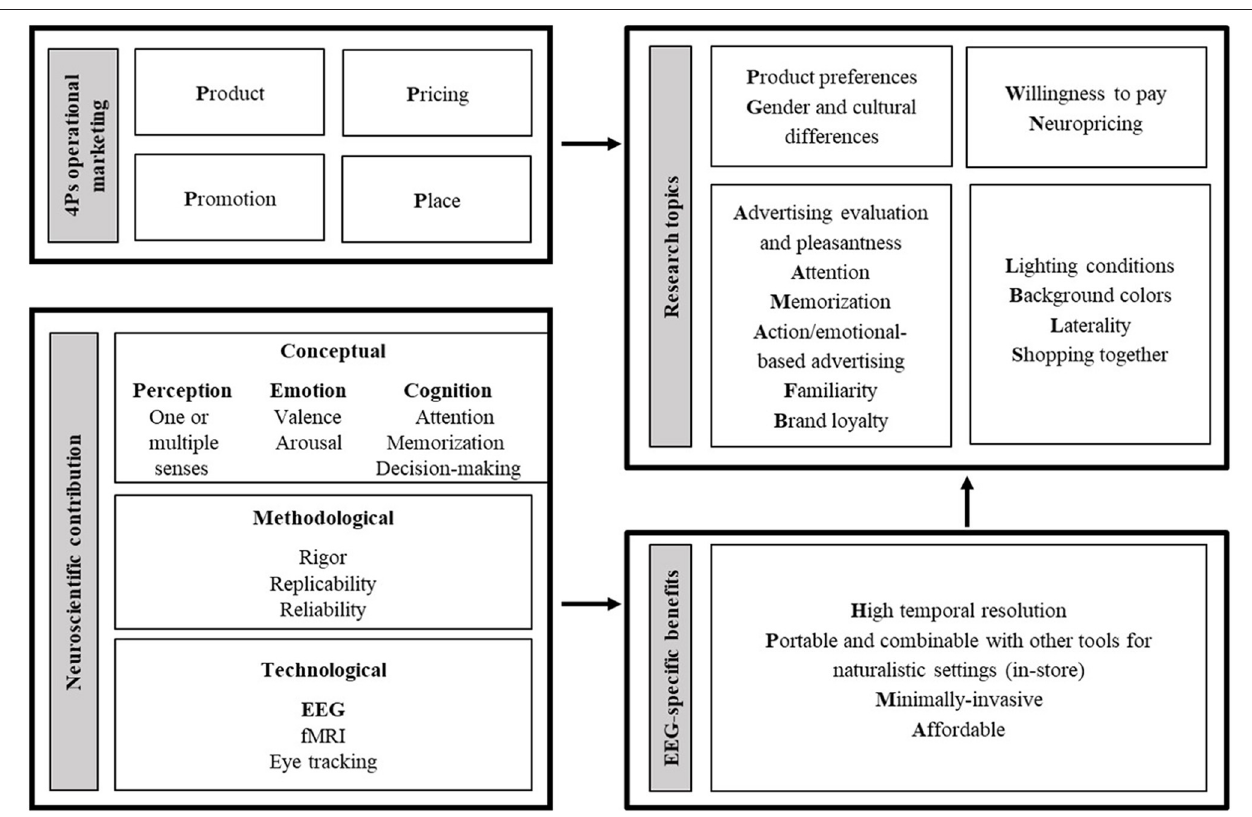
FIGURE 1 | Conceptual framework. The four Ps of operational marketing indicate a map of the research topics ranging from brand loyalty to pricing. Research in this area can be improved by the adoption of tools from neuroscience. In addition to the technological contribution (and the EEG-specific strengths highlighted in this review), marketing researchers can also benefit from the conceptual and methodological contributions offered by the neuroscience literature.